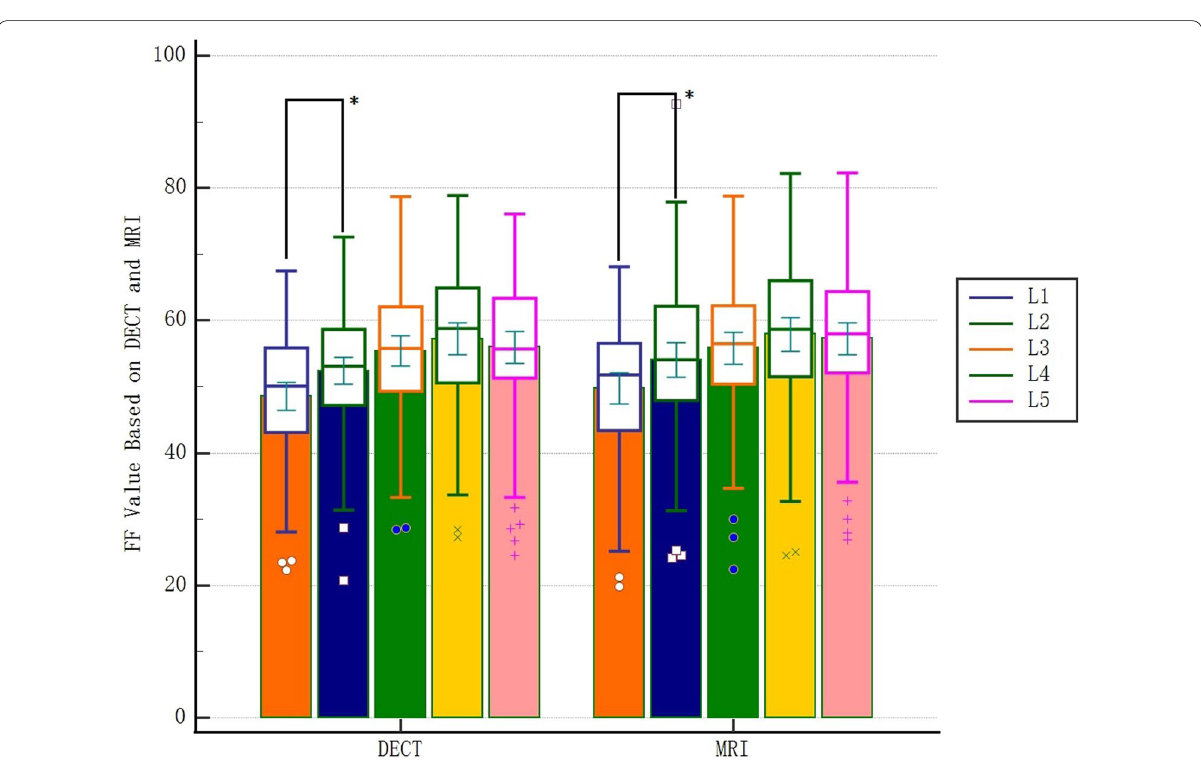
Fig. 3 The FF values of 1st to 5th vertebrae based on DECT and MRI. * p < 0.05 DECT: Dual-energy computed tomography, MRI magnetic resonance imaging, FF fat